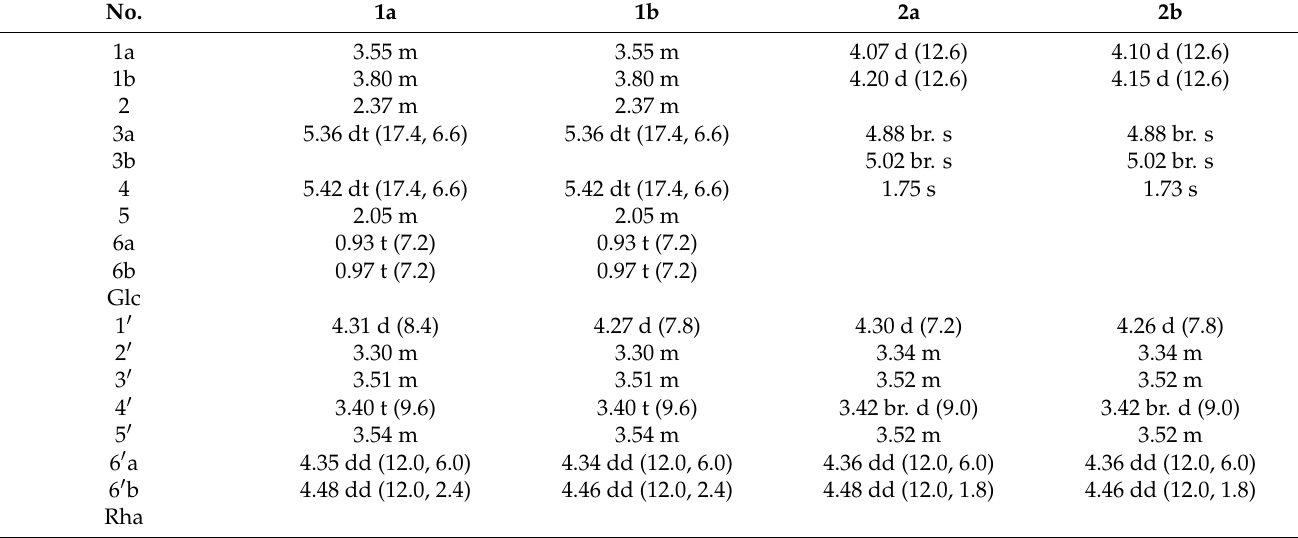
Table 1. 1 H NMR (600 MHz) data of compounds 1 – 2 from L. robustum in CD 3 OD a